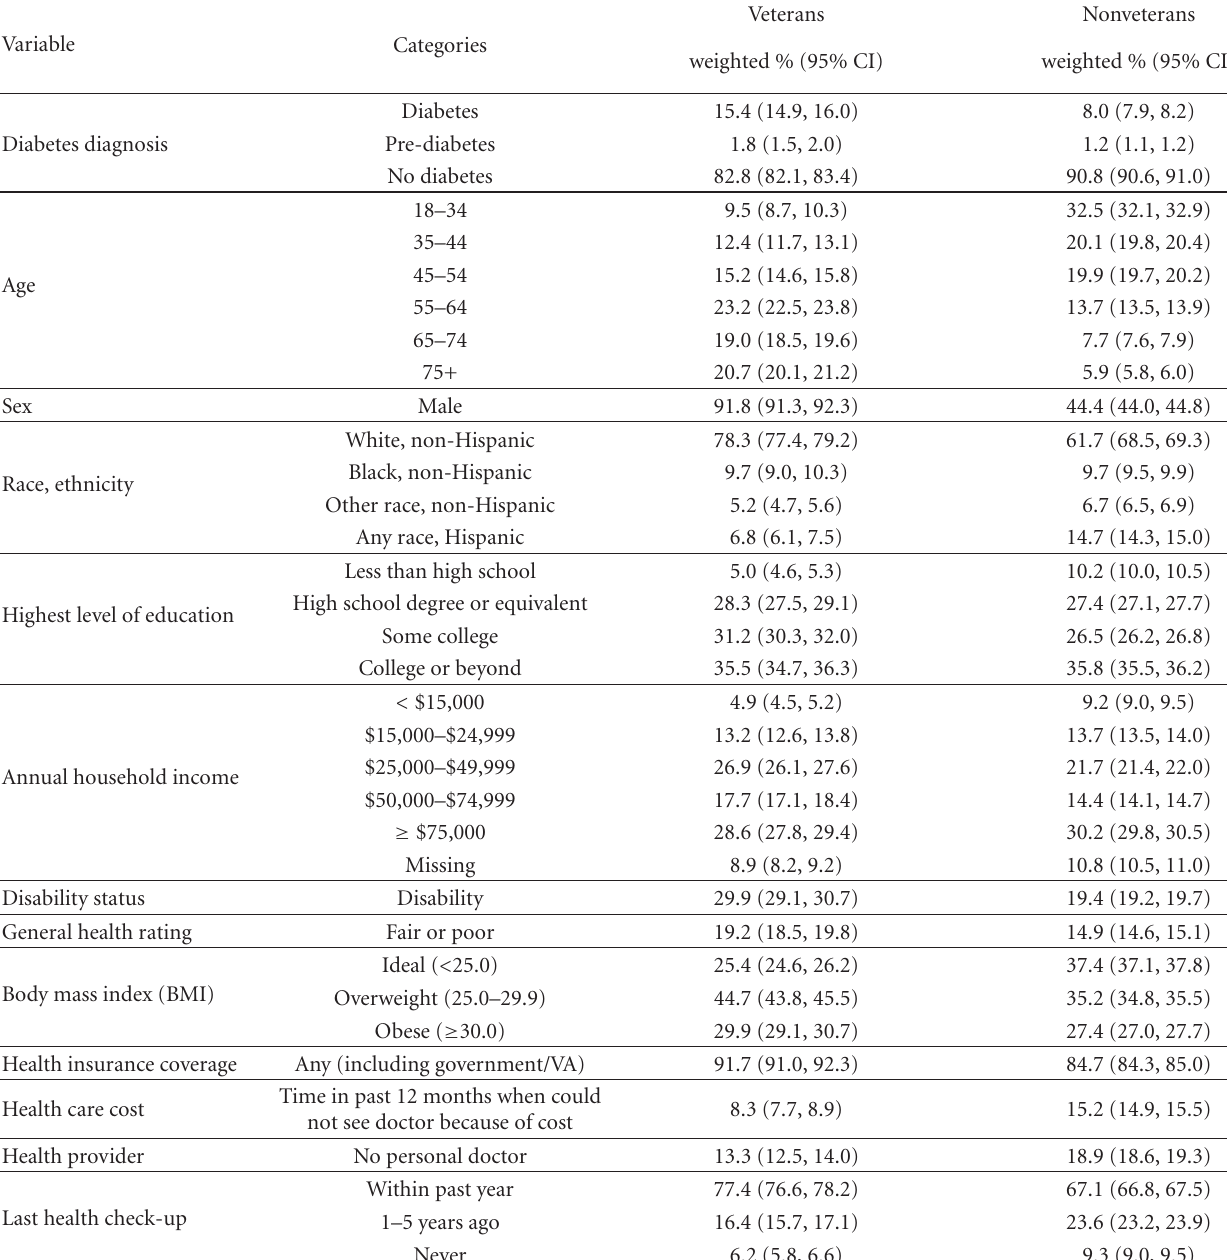
Table 1: Demographic and health characteristics of veterans and nonveterans in the United States, 2009 Behavioral Risk Factor Surveillance